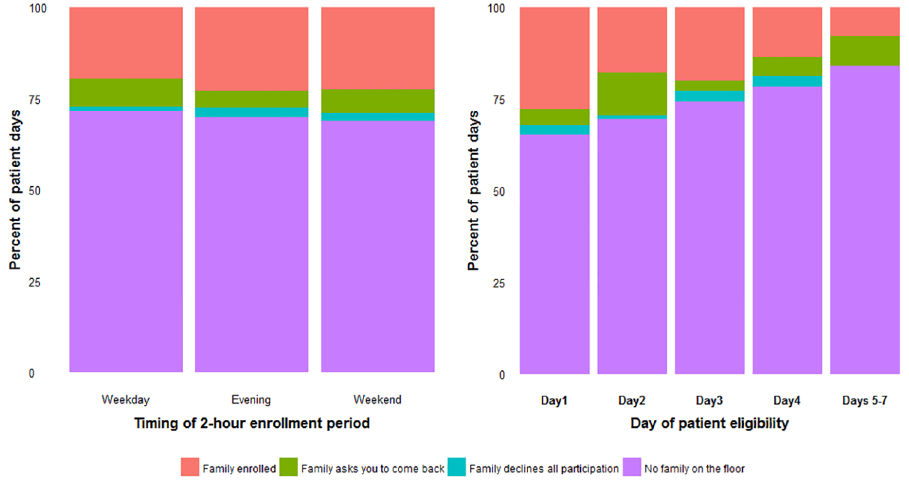
Fig 2. Patient-day level analysis of family presenceand enrollment in the medical intensive care unit. The followingpatients were excludedfrom day-levelanalysis:Patients without English-speakingfamily members, patients with ICU lengthof stay > 24 hours who were dischargedbefore the first 2-hour enrollment period, patients for whom clinicianpermissionto approachfamily members was not obtained,and two potentially eligiblepatients who were mistakenly not addedto the daily enrollment list on their 1 st day of eligibility.If the first proxy enrolledfor a patient was not the legal healthcareproxy, subsequent days spent attempting to locate the legal proxy were excludedfrom